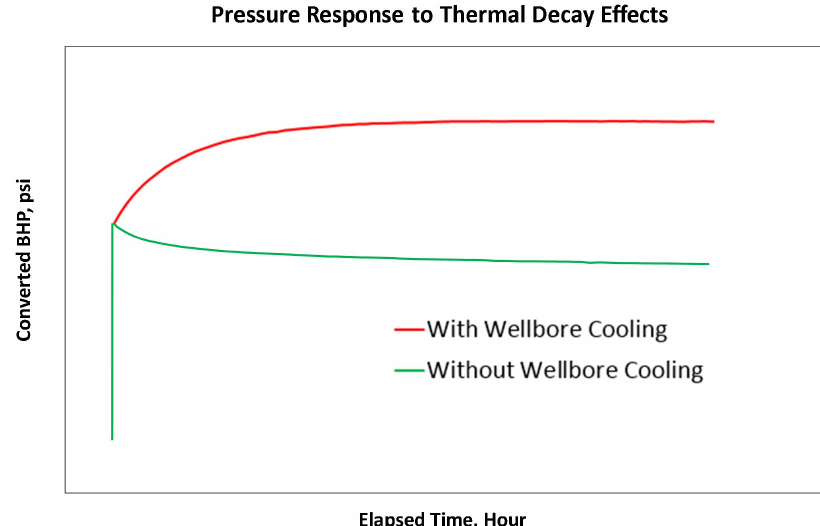
Figure 6—Wellbore cooling effect (Halliburton,